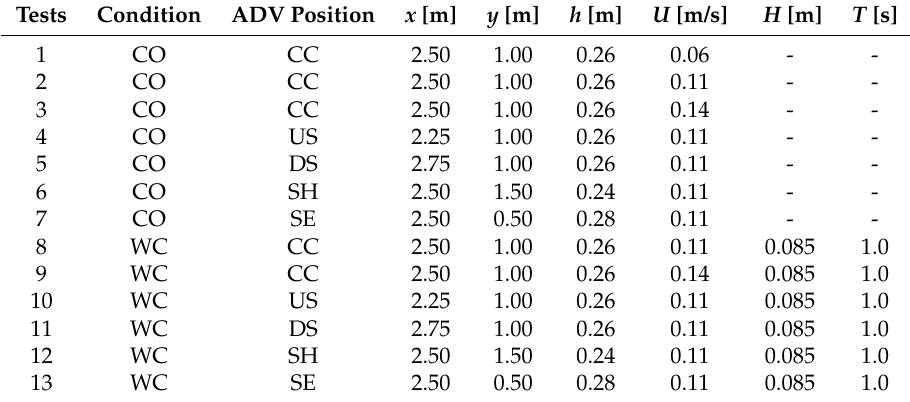
Table 1. Hydrodynamic conditions for all Tests: current only (CO) or waves plus current (WC), coordinates of the location of the Acoustic Doppler Velocimeter (ADV), local water depth h , mean current velocity U , wave height H and wave period T